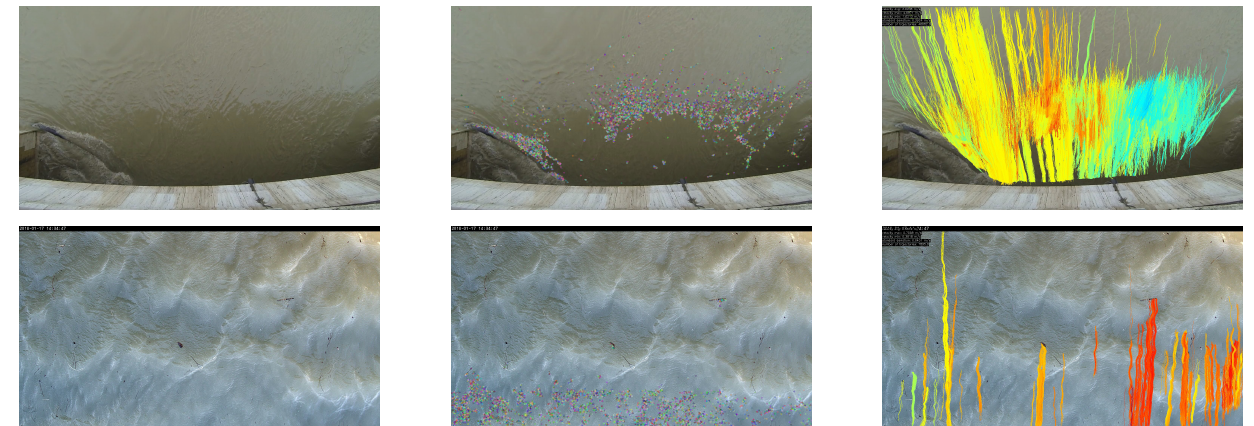
Figure 3. ( Top ) a video sequence acquired on the Tevere river, ( Bottom ) a sequence acquired on the Secchia river; ( Left ) Input frame of the video sequence, ( Middle ) FAST features extracted from the input frame, and ( Right ) trajectories inferred by the OTV